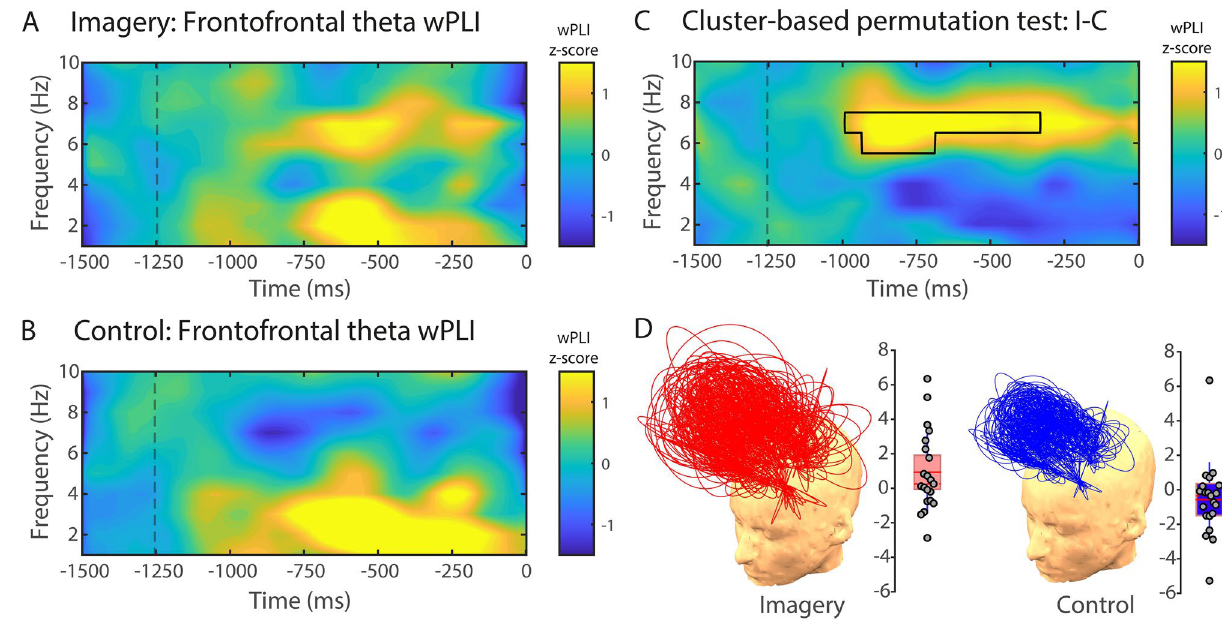
Figure 3. Theta phase-synchrony between inter-hemispheric frontal electrode pairs. wPLI (1–10 Hz) for visual imagery ( A ) and control ( B ) conditions. ( C ) Cluster-based permutation test comparing visual imagery and control conditions. The area highlighted in the time–frequency chart depicts a significant wPLI cluster between conditions (visual imagery minus control) in the theta band (5–7 Hz). ( D ) Region of interest (ROI) for phase-synchrony analysis. Only interhemispheric frontofrontal pairs of channels were considered for the analysis (see Sect. 2.8 for details). wPLI values are expressed in standard deviations (z-scores) in reference to the baseline (− 1500 to − 1250 ms). Trial length (− 1500 ms) is relative to response time (0 ms). ( D ) Topographical representation of frontofrontal wPLI channel pairs and single-participant wPLI values for the imagery (left) and control (right) conditions. Each arc represents a pair of channels, and the height of the arc is its normalised value. Grey circles represent single-participant wPLI values for the cluster depicted in (C) for the imagery (left panel) and control (right panel) conditions. The red horizontal line represents the group mean, the rectangle represents SEM, and the red-dashed horizontal line represents the group